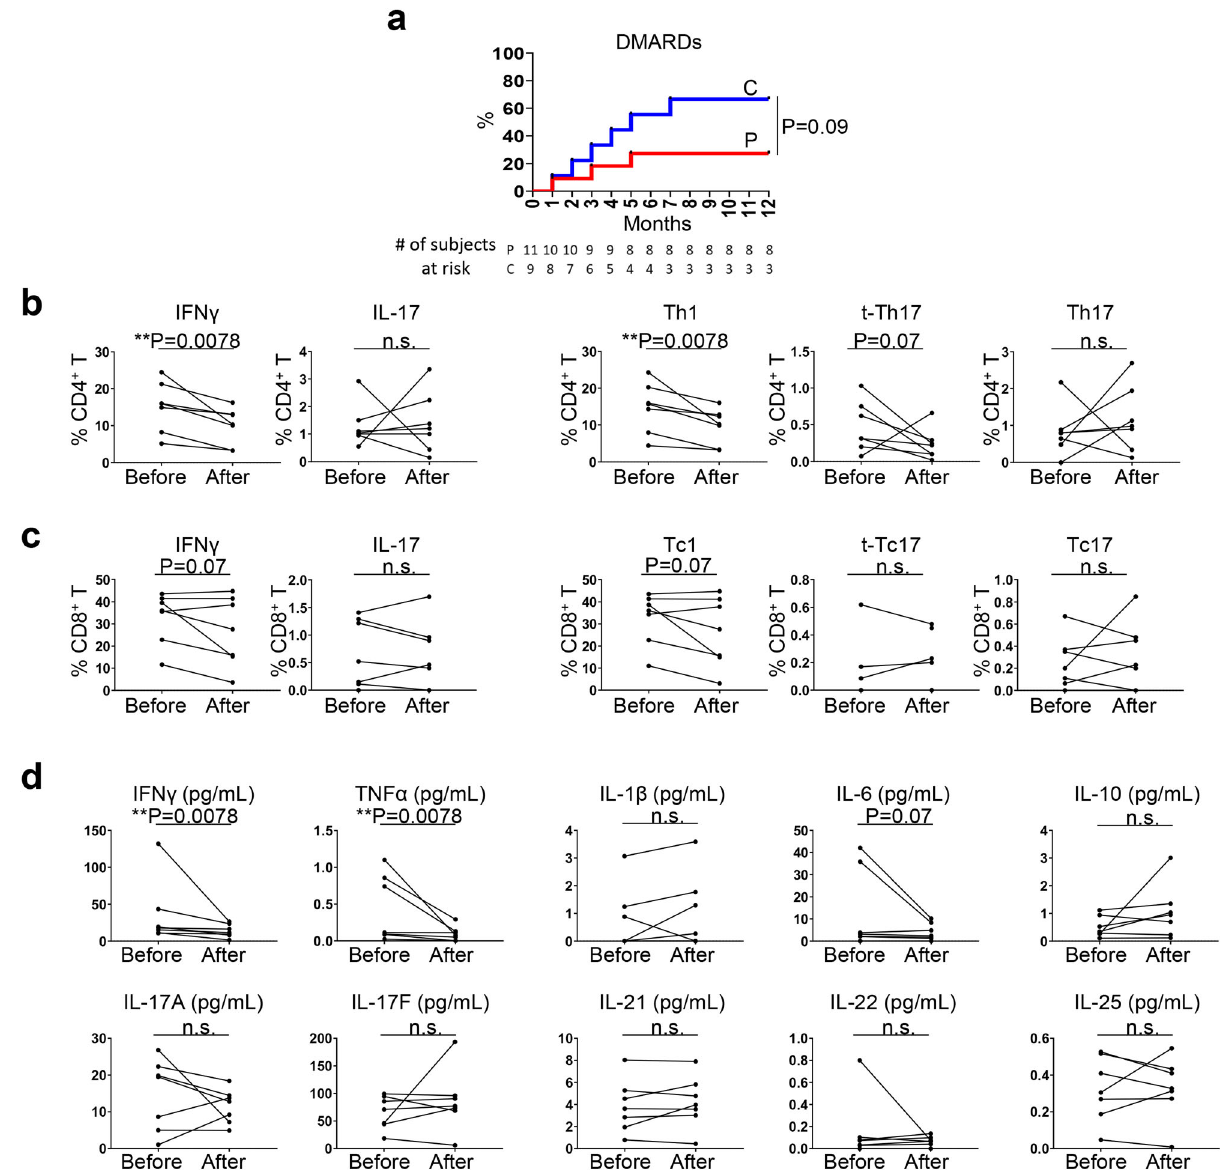
Fig. 6 Th17 and Tc17 cells are steroid-resistant. a Kaplan – Meier curves showing the proportion of patients whose steroid monotherapy failed and warranted disease-modifying anti-rheumatic drugs (DMARDs) over 12 months of follow-up based on ICI regimen. Two-sided Log rank test. P, PD-1 inhibitor arthritis; C, Combined ICI arthritis. b Percentage of interferon gamma (IFN γ )- and interleukin (IL)-17 – producing CD4 + T cells in PB (left panels) and Th1, transient (t-)Th17, and Th17 cells (right panels) before and after treatment of arthritis from 7 patients with arthritis-irAE. One-sided Wilcoxon matched-pairs signed-rank test. c Percentage of IFN γ - and IL-17 – producing CD8 + T cells in PB (left panels) and Tc1, t-Tc17, and Tc17 cells (right panels) before and after treatment of arthritis from 7 patients with arthritis-irAE. One-sided Wilcoxon matched-pairs signed-rank test. d Concentration of in fl ammatory cytokines in serum before and after treatment of arthritis from 7 patients with arthritis-irAE. One-sided Wilcoxon matched-pairs signed-rank test. Source data are provided as a Source Data fi